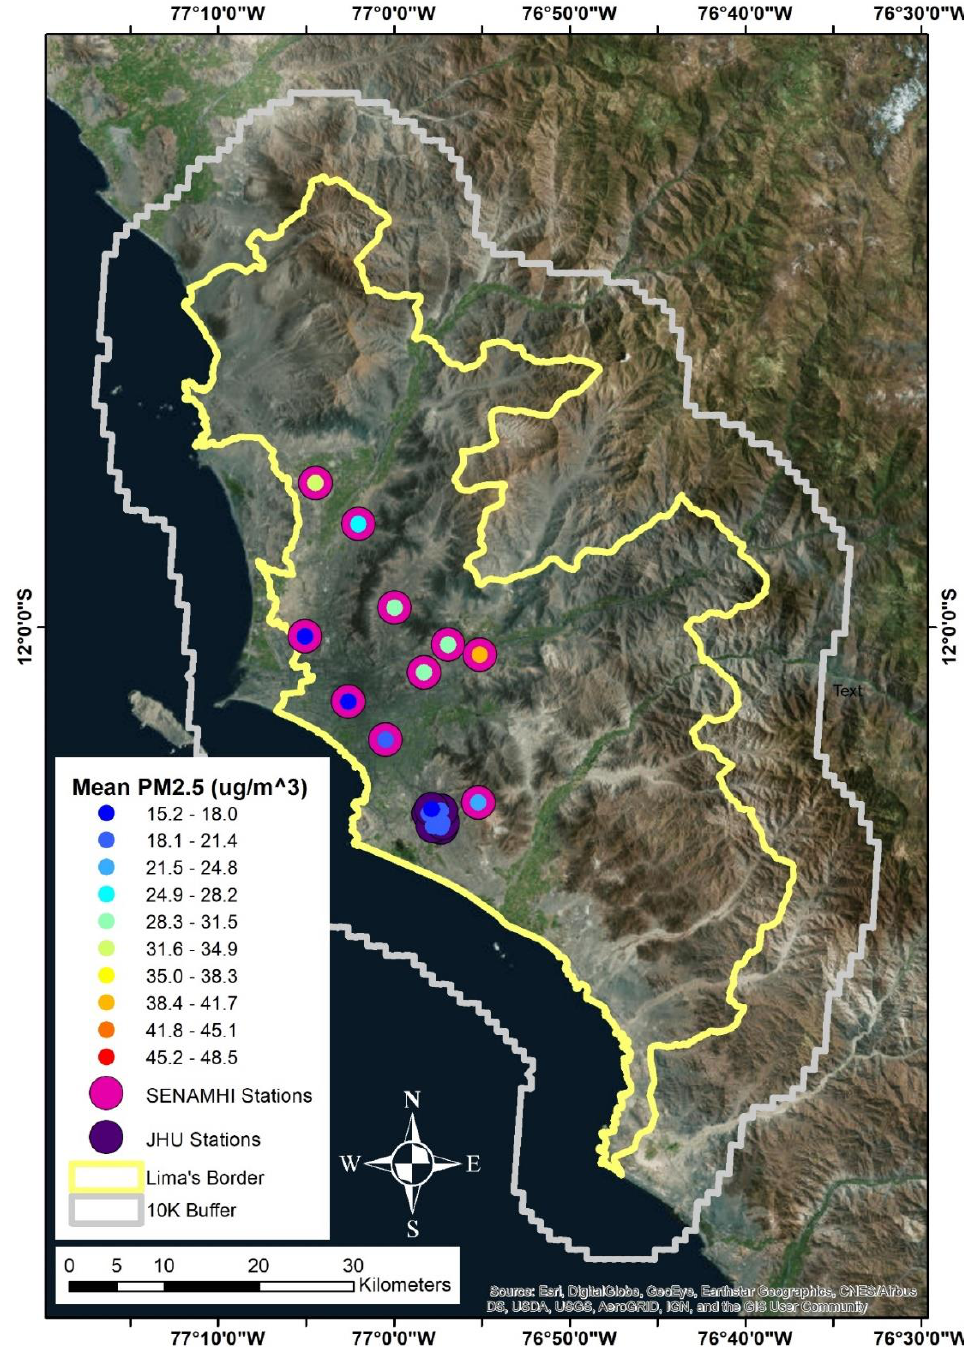
Figure 1. Study domain and location of air monitors. The yellow line details the Lima political border while the gray line details the 10 km buffer. The magenta circles denote the location, distribution, and overall mean PM2.5 concentrations in µg/m 3 of the Servicio Nacional de Meteorología e Hidrología del Perú (SENAMHI) monitor network, while the purple circles denote the same information for the Johns Hopkins University (JHU) monitor network.